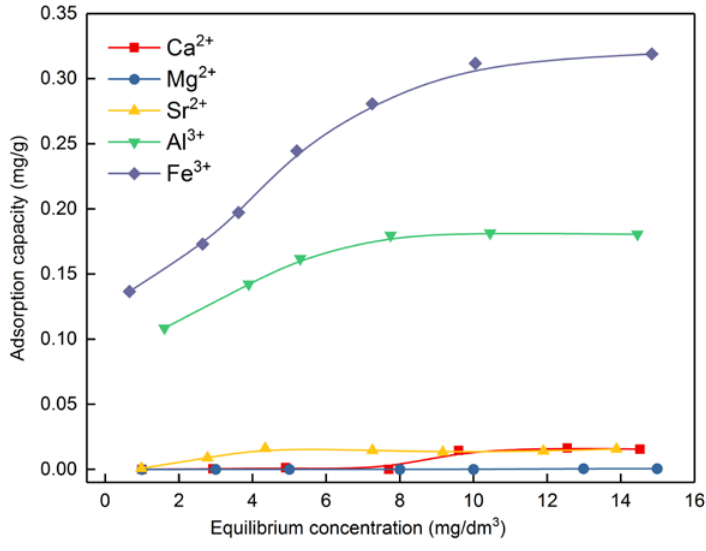
Figure 8. Adsorption capacity of metal ions on bastnaesite surfaces (pH = 8, 20 °C).